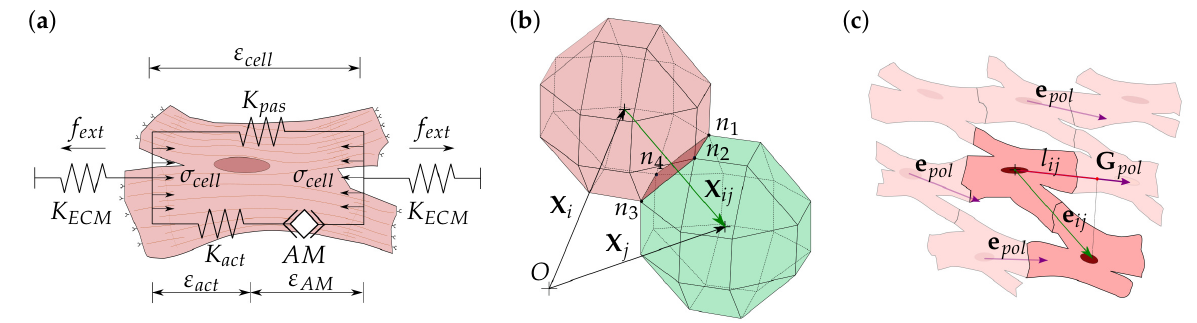
Figure 2. Mechanical modeling of the cell. ( a ) Equivalent mechanical model of the cell. σ cell is the cell internal stress generated due to the contraction of the actin–myosin ( AM ) filaments, ε AM , which causes cell internal deformation, ε cell . K act is the active stiffness of the cell generated by the active AM apparatus. K pas is the passive stiffness due to cell membrane and cell cytoskeleton resistance. Externally, the cell is attached to the extracellular matrix (ECM), with which the cell interacts by deforming the ECM, generating an opposing force, f ext , due to the ECM stiffness, K ECM . ( b ) Cell–cell contact vector, X ij , which can be calculated through the coordinate vectors X i and X j of the i th and j th cells, respectively. At any time step, cells in contact could satisfy (cid:107) X ij (cid:107)≤ 2 r . Any face in contact, defined by the nodes ( n 1 : n 4 ), loses the capacity to interact with the ECM. ( c ) Cardiac cell establishes stable cell–cell interactions, cell junctions (CJs), when the direction of the cell contact vector, e ij , is consistent with the cells global polarization direction, G pol . G pol is calculated through the individual cell polarization direction, e pol . To compare e ij and G pol , the projection, l ij , is defined for each pair of cells in contact, being considered as a CJ when l ij ≥ l min , and (cid:107) X ij (cid:107) = 2 r